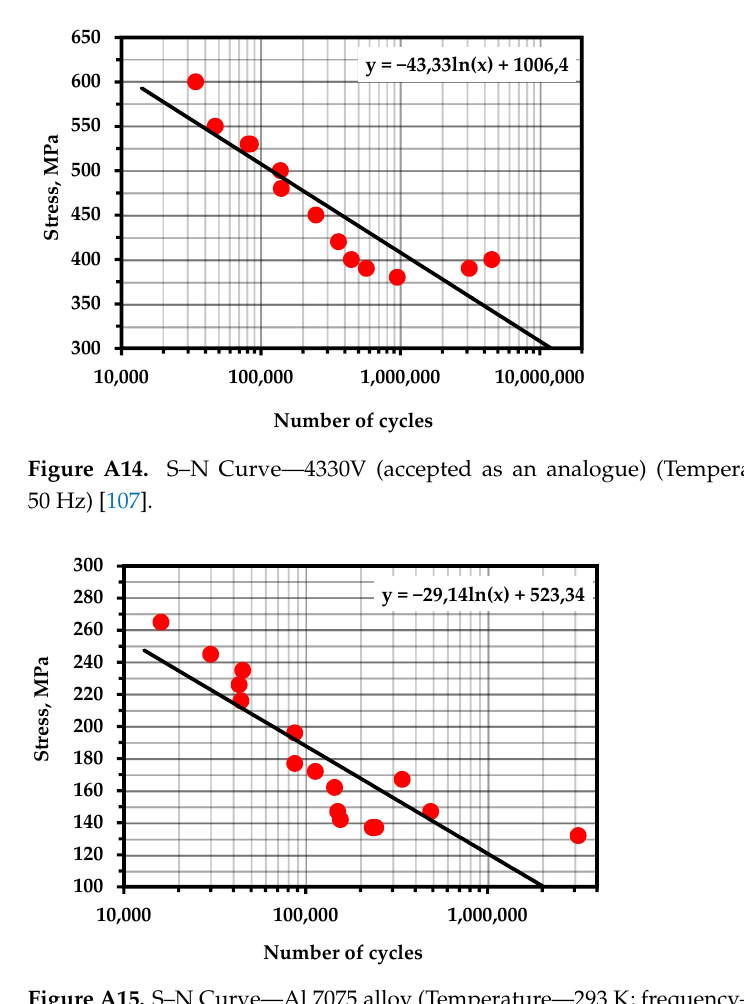
Figure A16. S–N Curve—Steel S355JR (accepted as an analogue) (Temperature—293 К ; frequency— 30 Hz) [105]. Figure A17. S–N Curve—Steel M250 (Temperature—293 К ; frequency—60 Hz) [108].